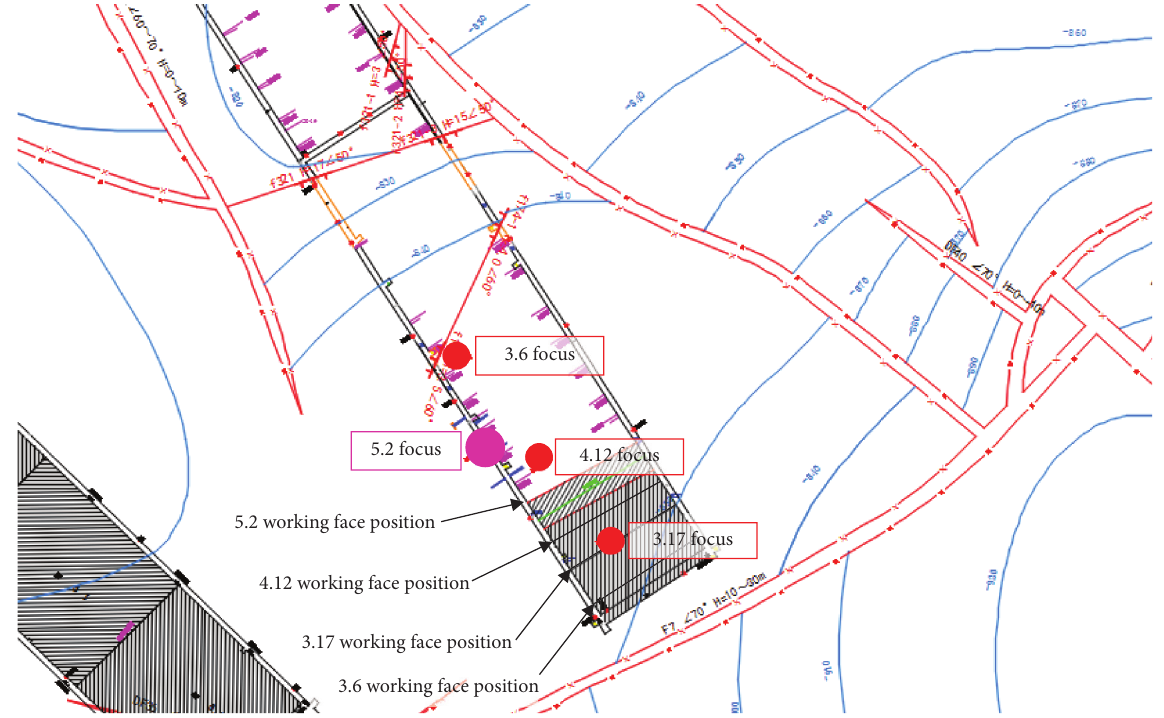
Figure 13: Location of four large energy microseismic events.